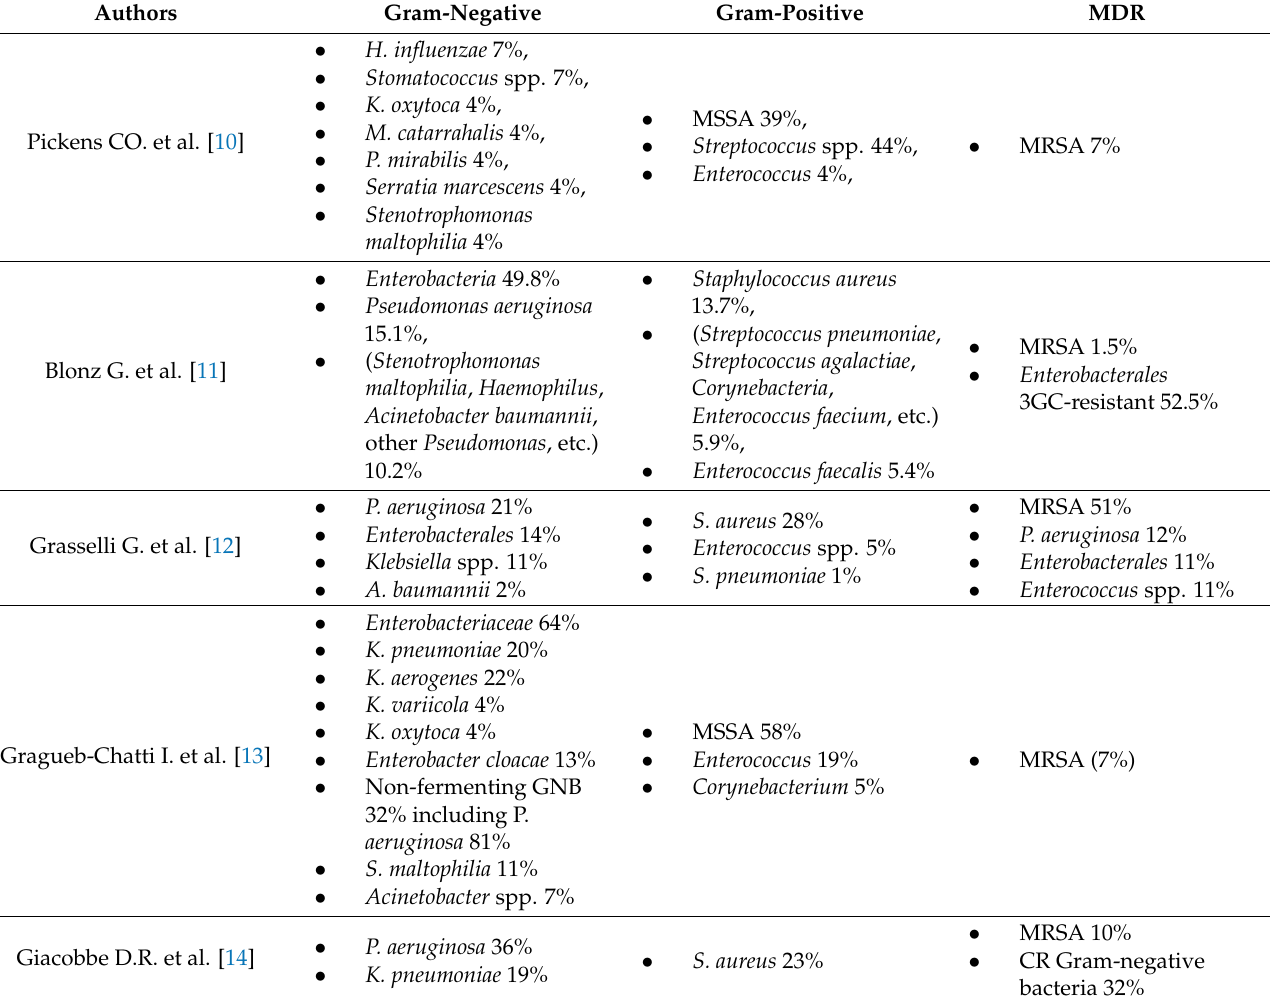
Table 2. Etiology of VAP in published